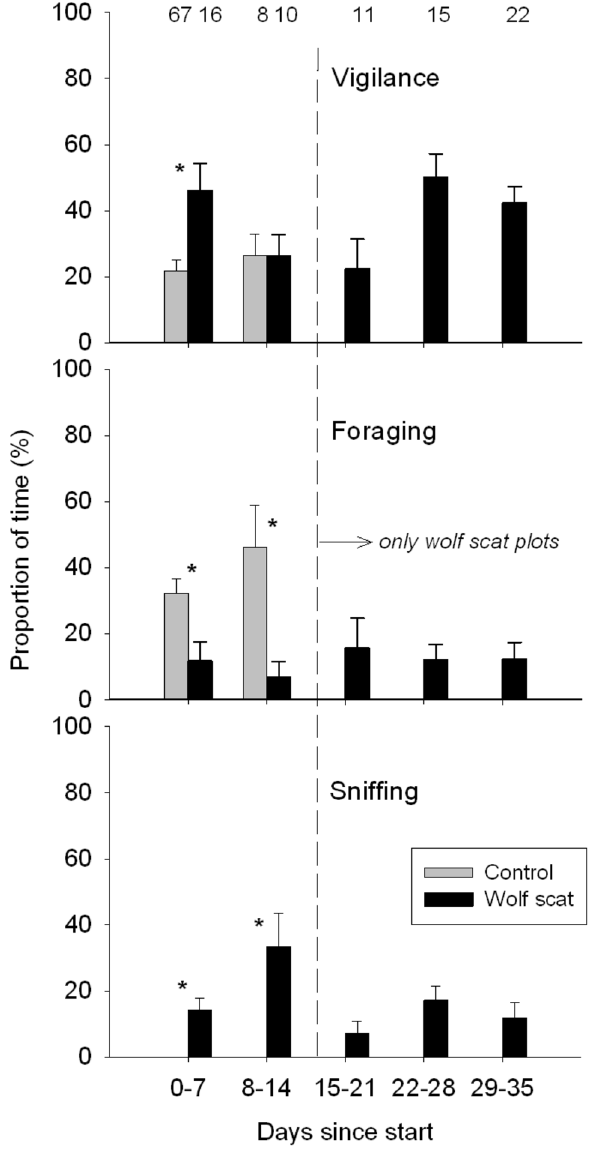
Figure 2. Duration of behavioral response of red deer to predator scent. Average percentage of time (± SE) red deer were vigilant, foraging and sniffing on control plots (grey bars) and plots with fresh wolf scat (black bars). Behavior is shown for the first and second week of the experiment, when both control and wolf scat plots were present. Subsequently, only wolf scat plots have been monitored up to 5 weeks after adding wolf scat. Significant differences between control and wolf scat plots within the first and second week are indicated by the asterisks (at P < 0.05 with Mann Whitney